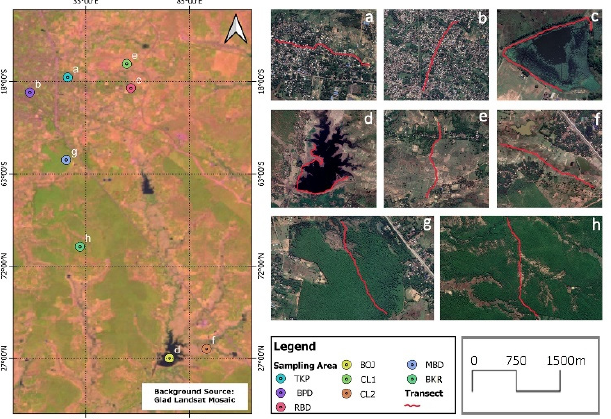
( a ) TKP = Takatpur, ( b ) BPD = Baripada, ( c ) RBD = Rani Bandh, ( d ) BOJ = Borjhor, ( e ) CL1 = Cropland1, ( f ) CL2 = Cropland2, ( g ) MBD = Manchabandha, ( h ) BKR =